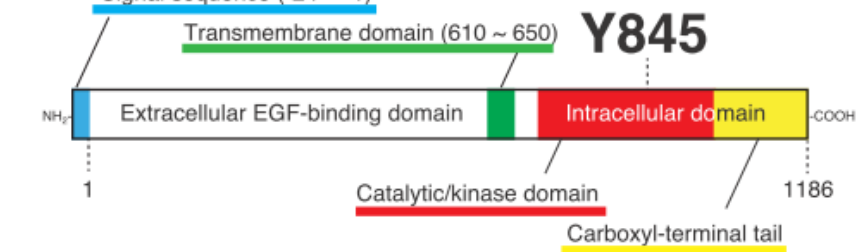
Figure 1. Schematic structure of EGFR. The translational protein product of the human EGFR consists of a single polypeptide of 1210 amino acids. Upon protein maturation that involves extensive glycosylation of the amino-terminal EGF-binding extracellular domain, the amino-terminal 24 amino acids are removed as a signal sequence (as indicated by a blue area), by which the mature protein becomes a polypeptide of 1186 amino acids. In addition to the extracellular domain, EGFR contains a single transmembrane domain at almost the center of the protein (green) and a carboxyl-terminal sequence that contains the catalytic/kinase domain (red) and a non-catalytic tail sequence (yellow), between the two where the Src phosphorylation site Y845 and several tyrosine residues to be autophosphorylated are